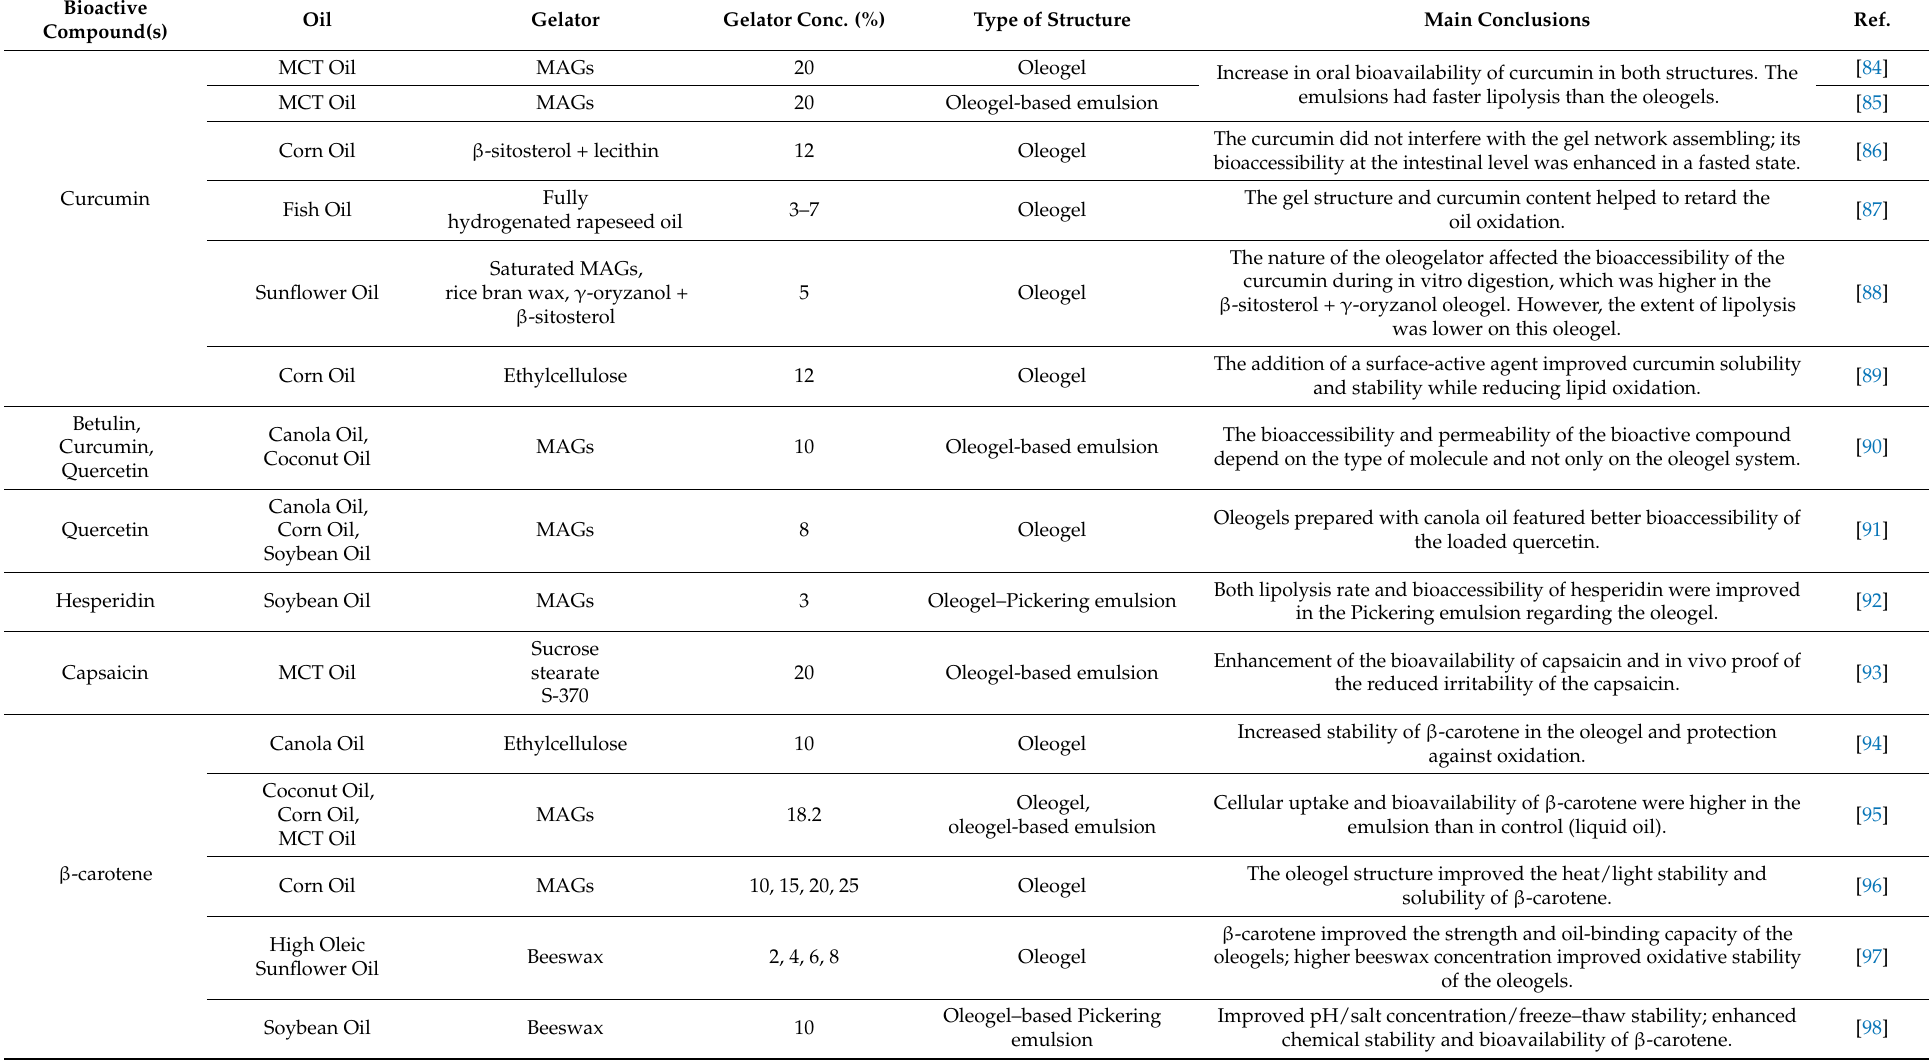
Table 1. Food-grade oleogel systems with proven effectiveness in the delivery of bioactive